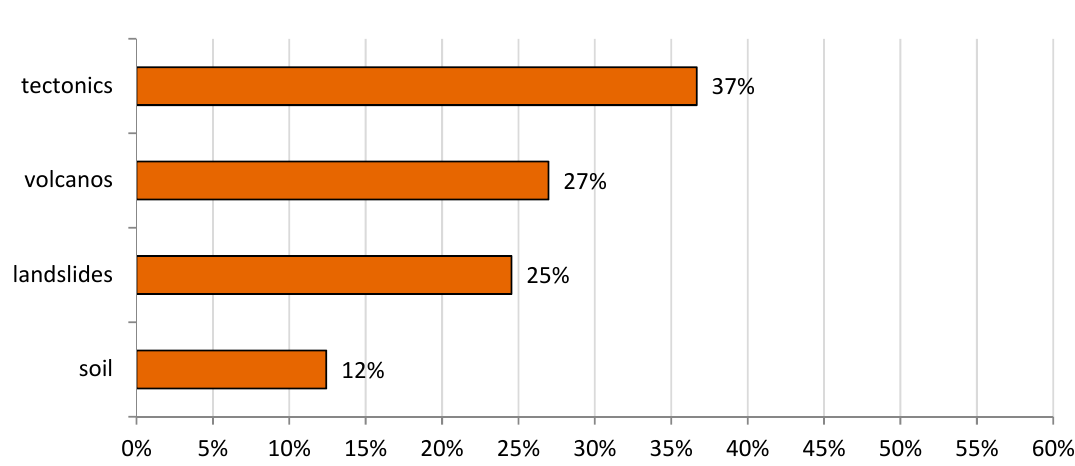
Figure 7. Thematic fields of geosphere related TerraSAR-X proposals, sorted by frequency addressing small- and large-scale surface deformations caused by the Earth crust’s dynamic (tectonics), volcanic activities, landslides and soil mapping including erosion.